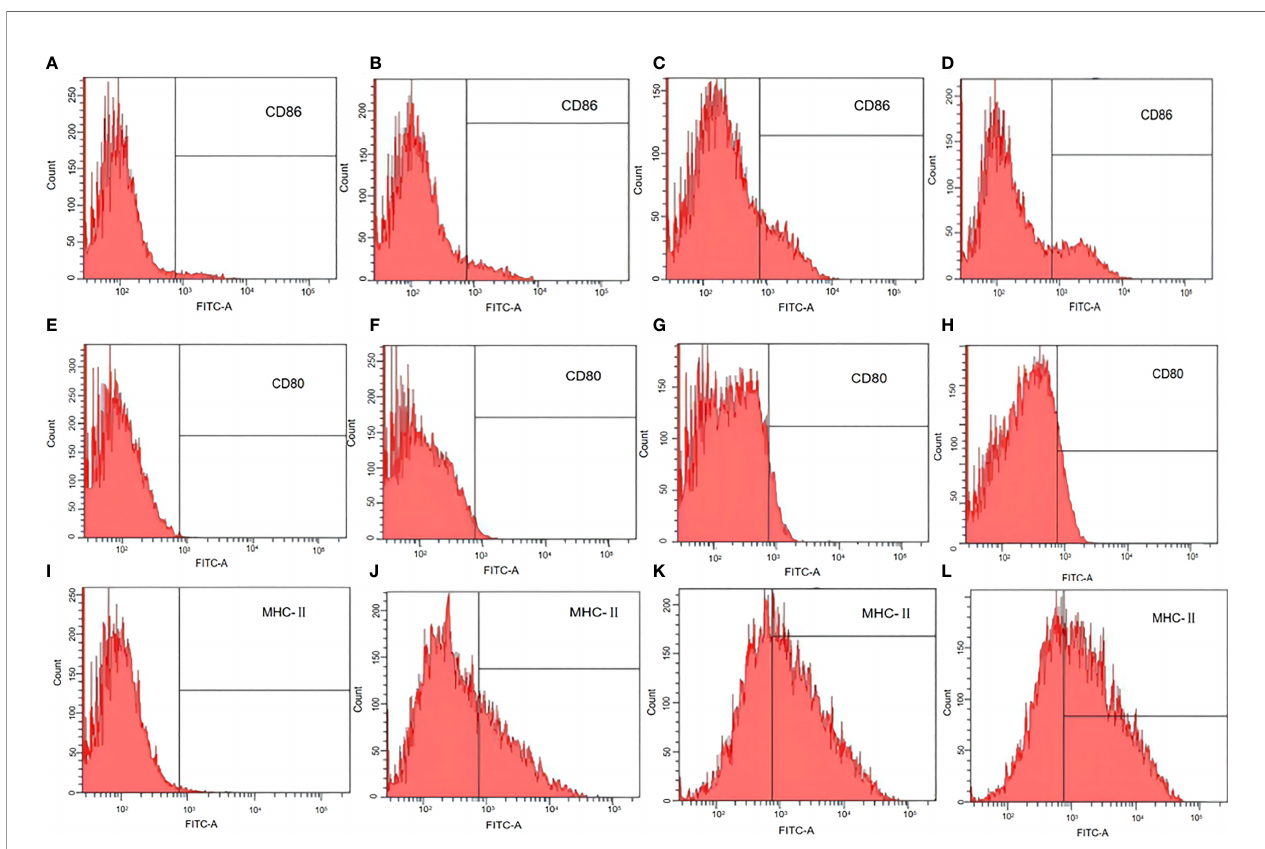
FIGURE 6 | Flow cytometry assay of marker expression by mature dendritic cells (DCs). DCs were treated with plasmid DNA (1 mg/mL), BGs loaded with plasmid DNA (1000 bacteria/cell), or lipopolysaccharide (LPS, 1 m g/mL). MHC class II, CD80, and CD86 in mature DCs were analyzed using fl ow cytometry. Expression of (A) CD86 in untreated DCs, (B) CD86 in DCs treated with plasmid DNA, (C) CD86 in DCs treated with plasmid DNA – loaded BGs, (D) CD86 in DCs treated with LPS, (E) CD80 in untreated DCs, (F) CD80 in DCs treated with plasmid DNA, (G) CD80 in DCs treated with plasmid DNA – loaded BGs, (H) CD80 in DCs treated with LPS, (I) MHC – II in untreated DCs, (J) MHC – II in DCs treated with plasmid DNA, (K) MHC – II in DCs treated with plasmid DNA – loaded BGs, and (L) MHC – II in DCs treated with